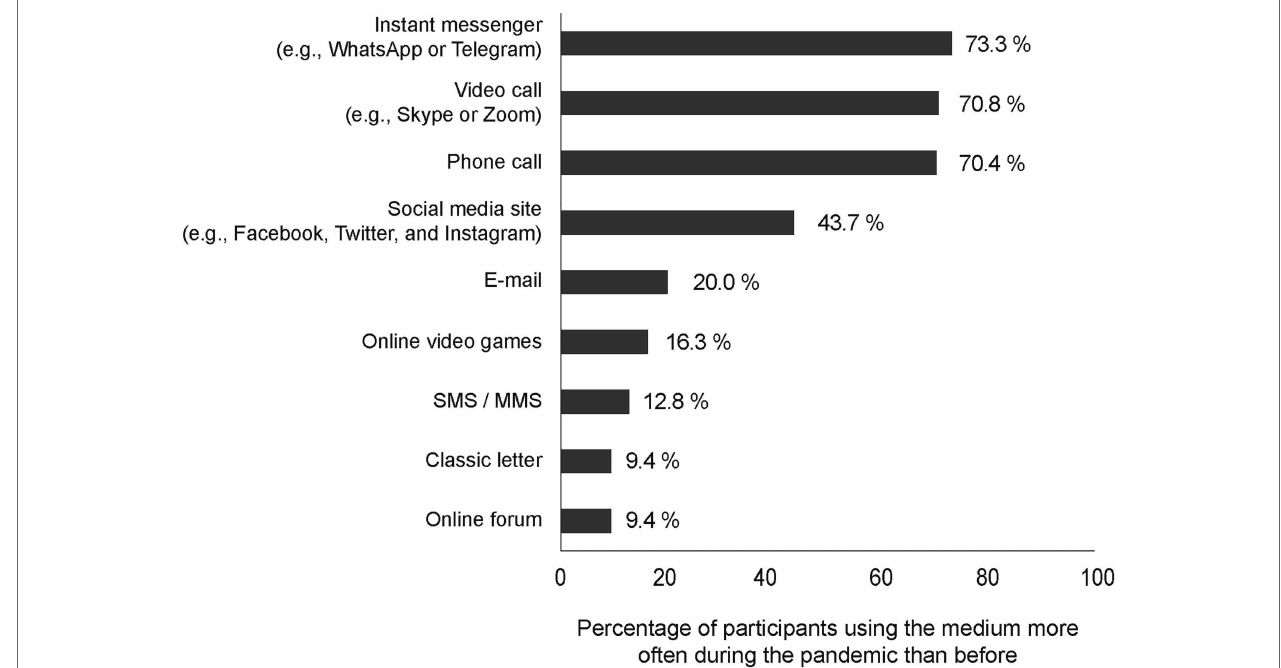
FIGURE 1 | Percentage of participants who reported using communication media more frequently in the context of leisure activities during the first nationwide lockdown than before the